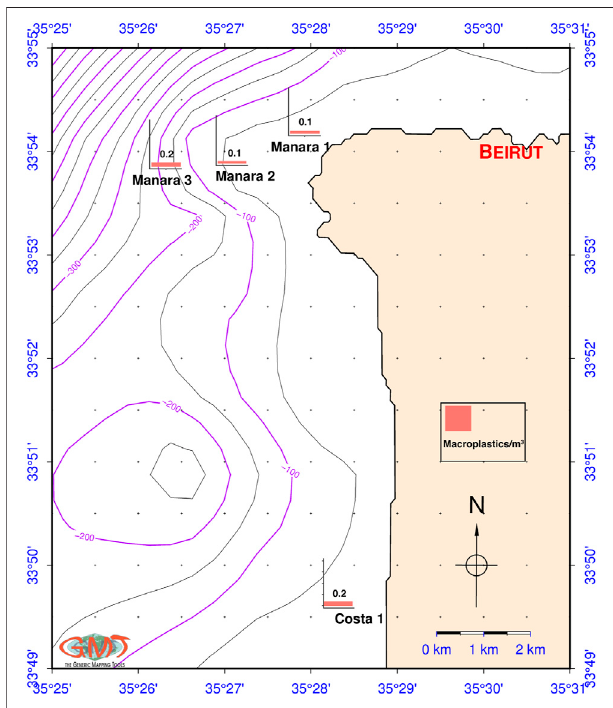
FIGURE 2 | The distribution and concentration (items/m 3 ) of macroplastics in Beirut marine area.